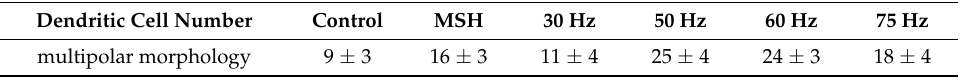
Table 1. The number of dendritic and multipolar cells ( n = 4). (MSH: Melanocyte-stimulating hormone). Dendritic Cell